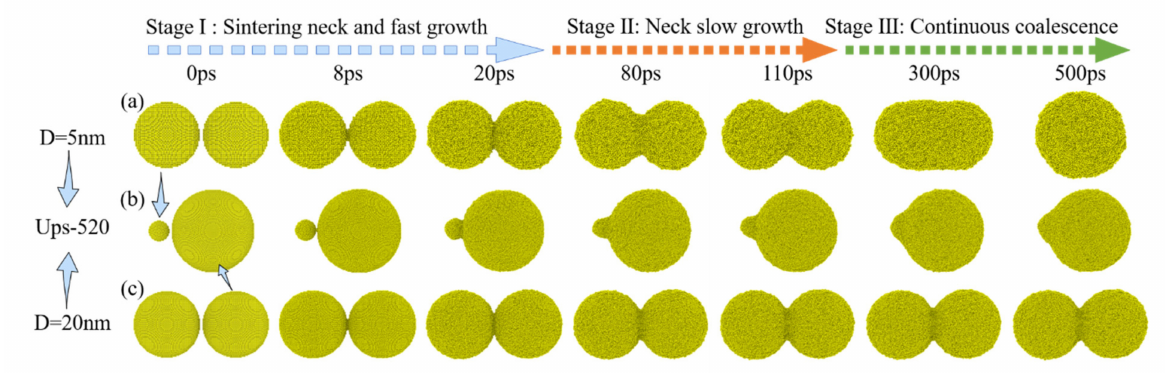
Figure 10. Morphology changes of different models during the sintering process corresponding to the sintering time, all of which are sintered at the same temperature (1000 K). ( a ) EPs-5 sintering